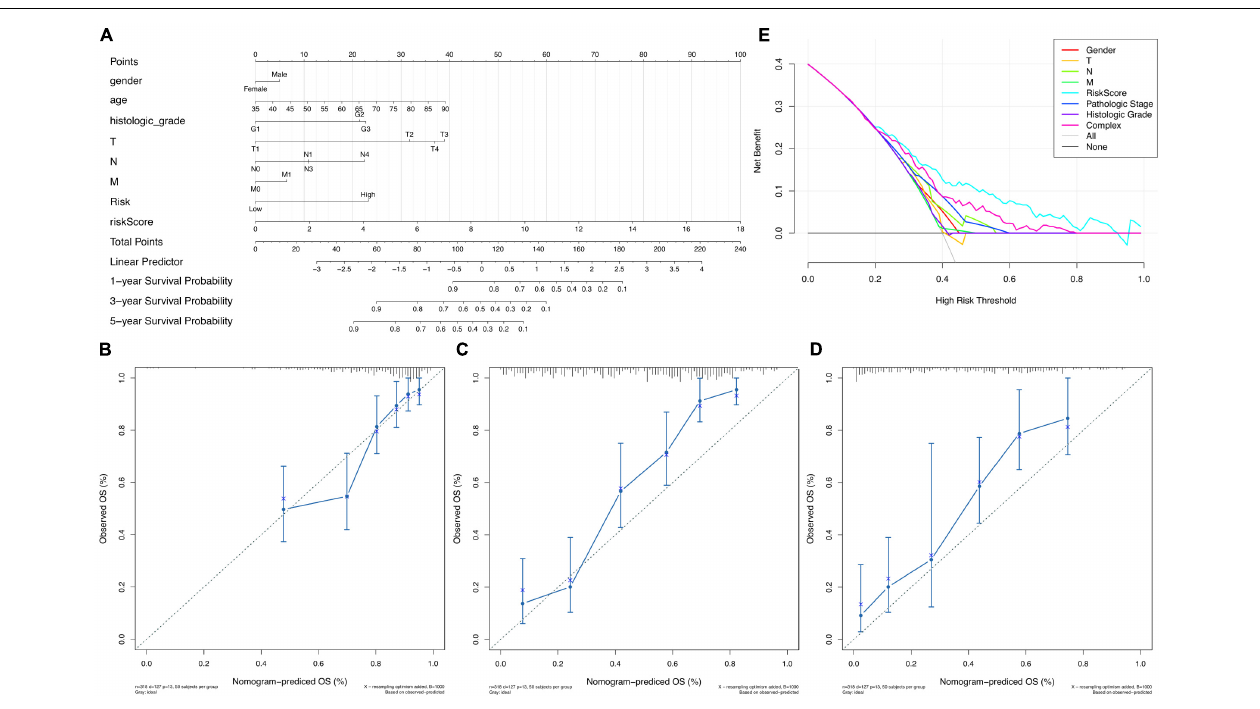
FIGURE 7 | Nomogram of overall survival (OS) prediction of patients with gastric cancer. (A) Nomogram of both the prognostic model based on 17 ferroptosis-related lncRNAs and the clinical pathological factors. (B–D) Calibration curve analysis of the 1-year (B) , 3-year (C) , and 5-year (D) survival prediction accuracy of the nomogram. (E) Decision curve analysis (DCA) of the clinical practicality evaluation of the